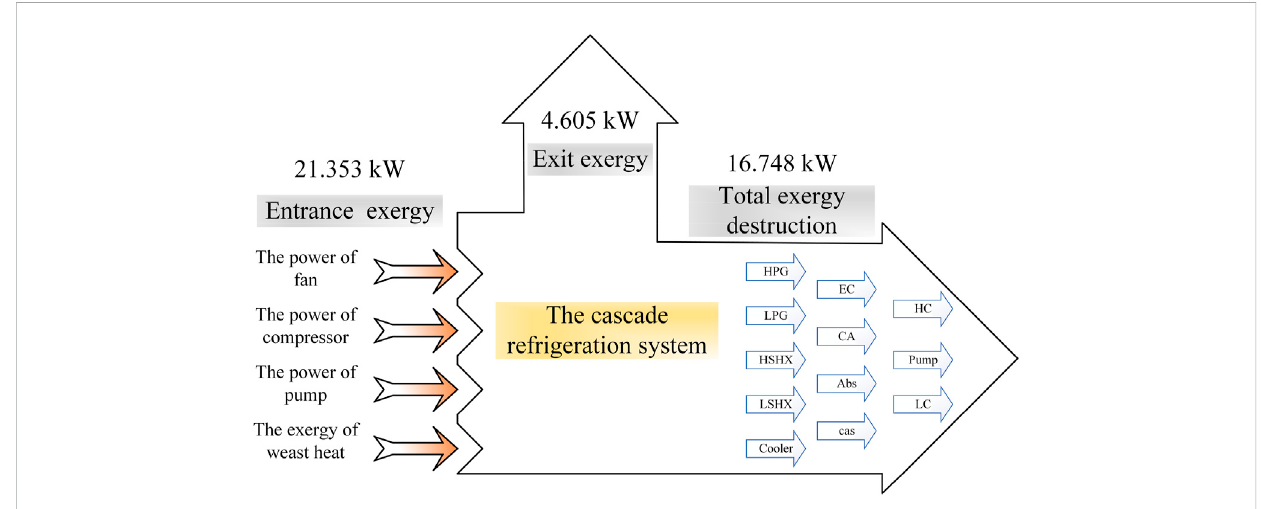
FIGURE 4 Grassmann diagram for exergy balance of the cascade